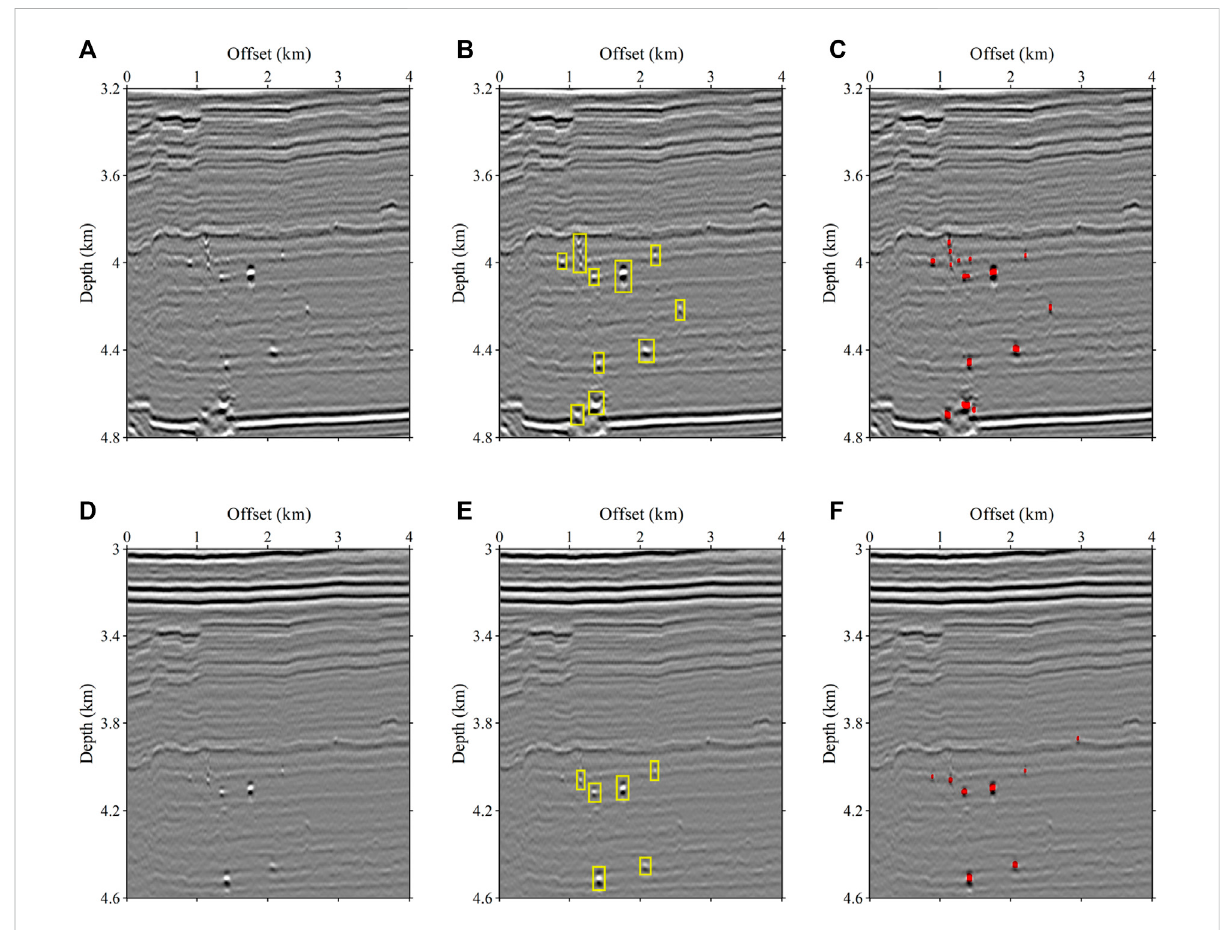
FIGURE 14 The imaging results and prediction results of the physical simulated data on the crossline section. (A) and (D) are the seismic images. (B) and (E) are the manually cave picking results. (C) and (F) are the overlaid display of seismic images and the predicted results.